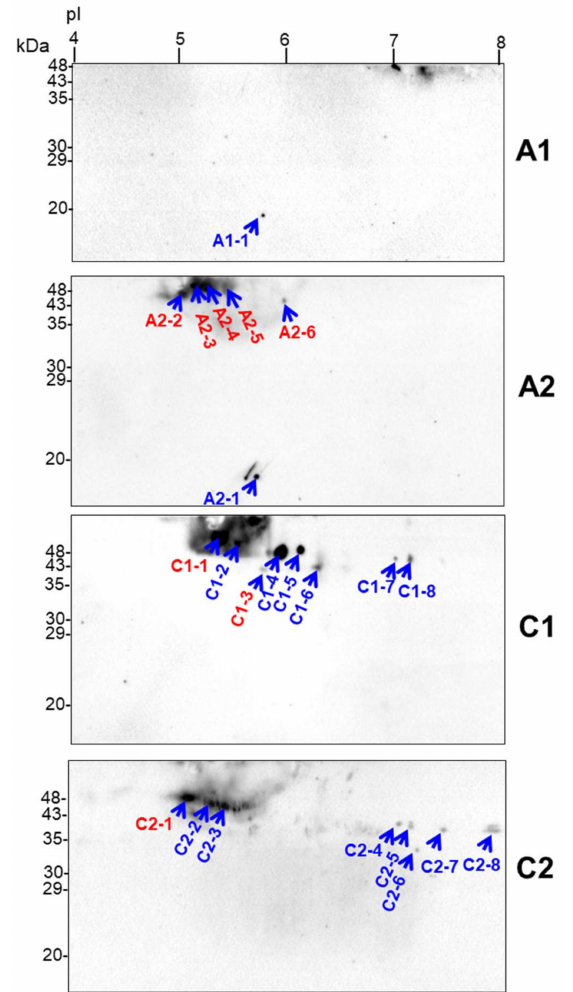
Figure 6. Representative pattern of dlps of “ Adelanto ” and “ Casper ” plants grown in moderate (A1, C1) and severe drought (A2, C2, respectively) immunodetected with antibodies directed against dehydrin K-segment [52] on two dimensional (2D) blots. Spots referring to detected proteins that were cut out from the respective 2D gels for protein identification by liquid chromatography-tandem mass spectrometry (LC-MS/MS, blue arrows ) also appear in Figure 1 (denoted in blue and red ). Proposed identities for those spots and all tryptic peptide data are indicated in Table S6. Identifiers of spots containing tryptic peptides specific to dehydrins are marked in red (remaining labels are shown in blue ). For molecular mass calibration (kDa) of protein spots, PageRuler Prestained Protein Ladder (Thermo Scientific, Gda´nsk, Poland) and Low Molecular Weight (LMW)-SDS Marker Kit (GE Healthcare Poland, Warsaw, Poland) are used. For calibration of spot isoelectric point (pI), Broad pI Kit (GE Healthcare) is applied. Further data found in the